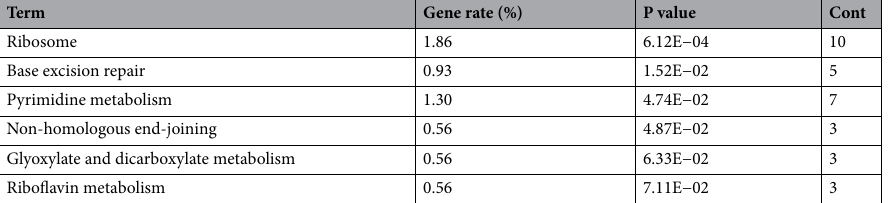
Table 2. The analysis of Kyoto Encyclopedia of Genes and Genomes pathway with genes in survival-associated AS events (the pathway analysis using the Kyoto Encyclopedia of Genes and Genomes (KEGG) pathway database 31–33